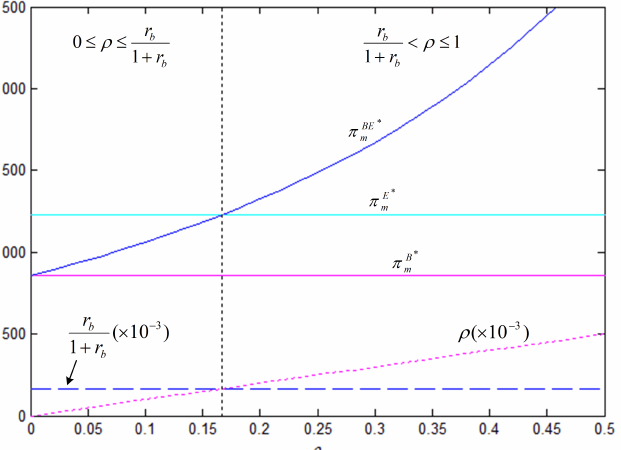
Figure 9. Comparison of the optimal q under three financing strategies ( θ = 5, r b = 0.2).